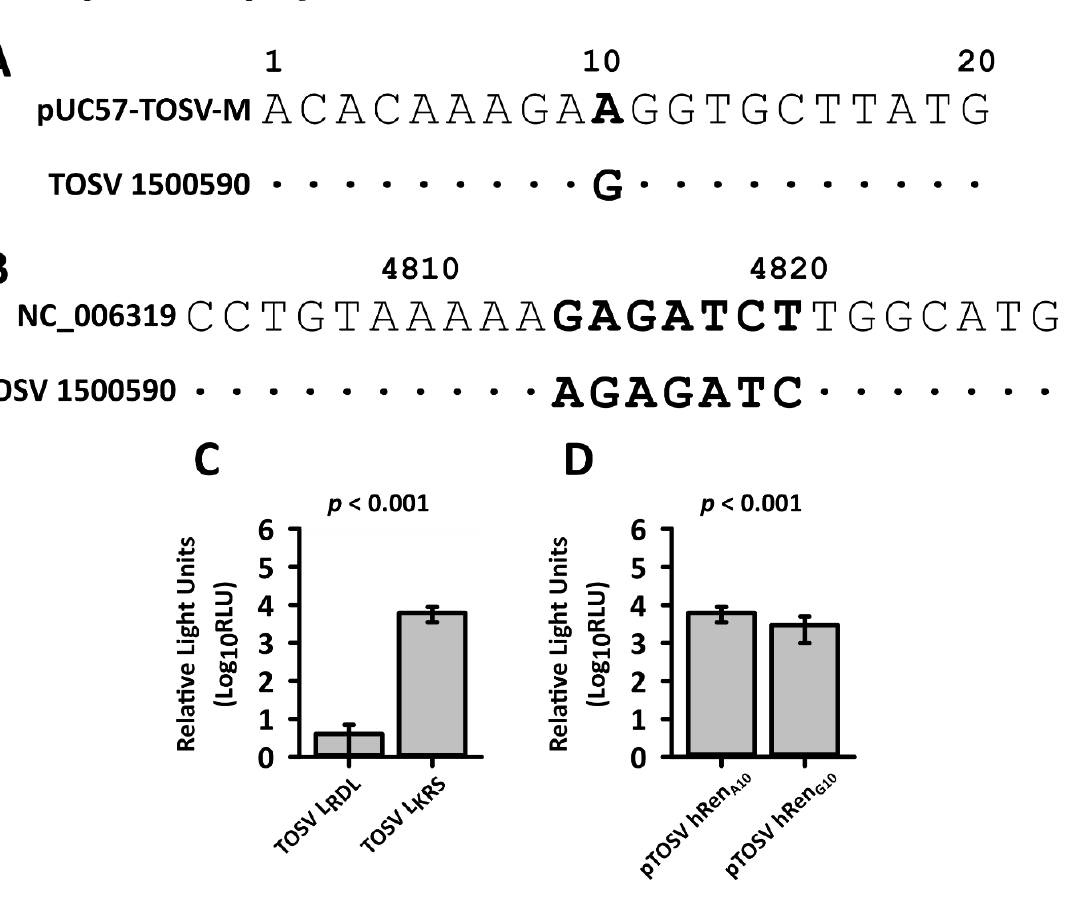
Figure 1. RNA sequencing of TOSV revealed critical errors in published TOSV sequences; regions in bold and (A) and (B) indicate sequence changes. ( A ) RACE analysis of TOSV identified a change at position 10 of the 5′ untranslated regions (UTR) of the M segment. As this was the segment on which the minigenome was based, this was introduced in the Renilla luciferase reporter plasmid to create pTOSV hRen G10 ; ( B ) Two critical changes in the L segment from that of GenBank submission NC_006319.1 were identified. This sequence only appears in this GenBank submission and not in other available sequences (see Table 1); ( C ) Replication of minigenome pTOSV hRen. After corrections to the L expression plasmid (TOSV L KRS ) minigenome replication was observed, N = 16; ( D ) G at position 10 of the 5′ antigenome UTR reduced replication in the minigenome replication system, N = 6. Two sample t test, error bars show standard deviations. Assays shown in ( C ) and ( D ) are representative of three independent experiments. RLU, relative light units.